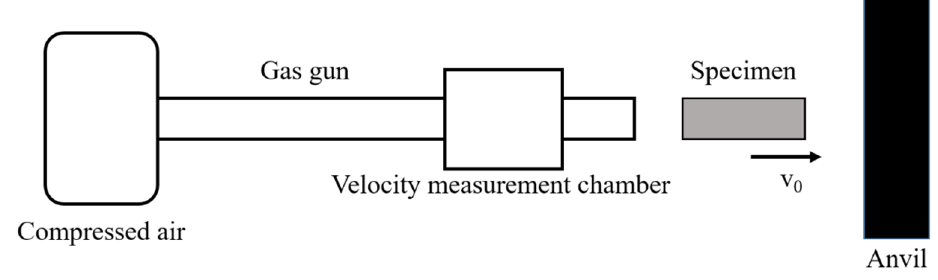
Figure 2. Schematic of a Taylor impact equipment.